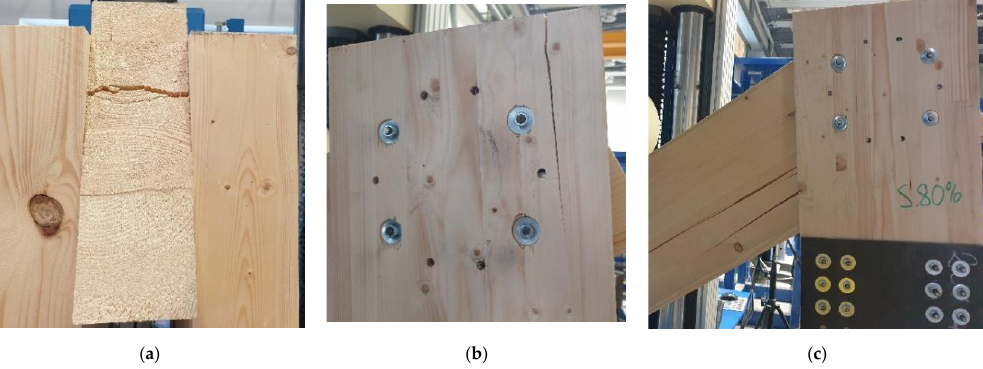
Figure 13. Experiment A: ( a ) failure without reinforced segments; ( b ) reinforcement with reinforced rung; and ( c ) breach with reinforced rung and struts (stands).